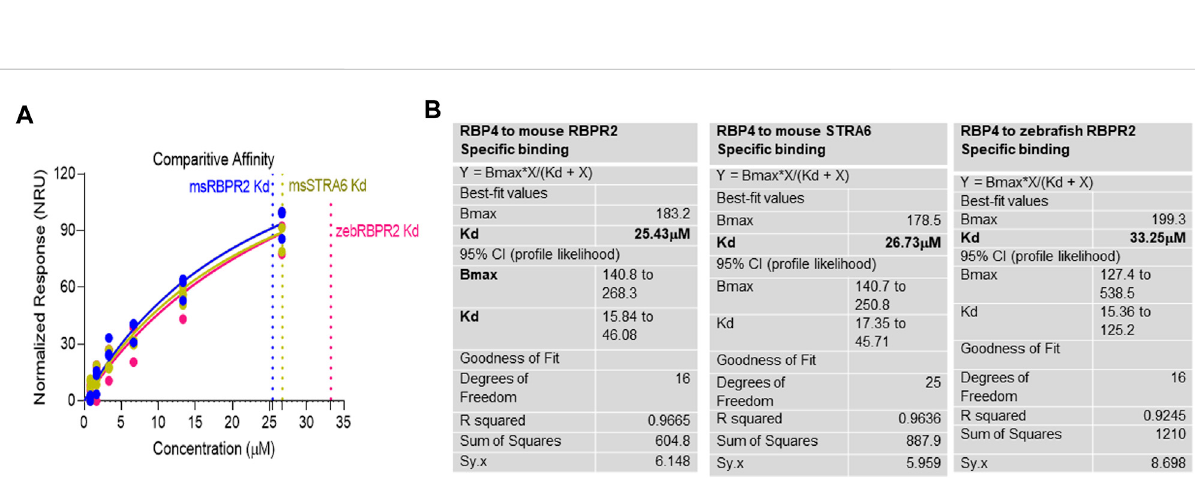
the previously discussed membrane receptor. Due to its lipophilic nature, all- trans -retinol requires a carrier protein to reach target organs (Quadro et al., 1999; Chelstowska et al., 2016; Borel and Desmarchelier, 2017; Martin et al., 2021). With the discovery of the liver-secreted protein retinol binding protein 4 (RBP4) in 1968 as the speci fi c carrier